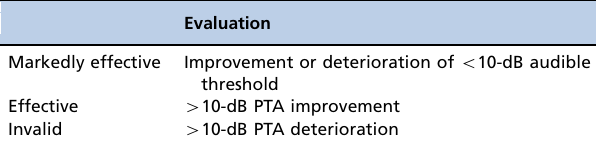
Table 1 - Efficacy evaluation